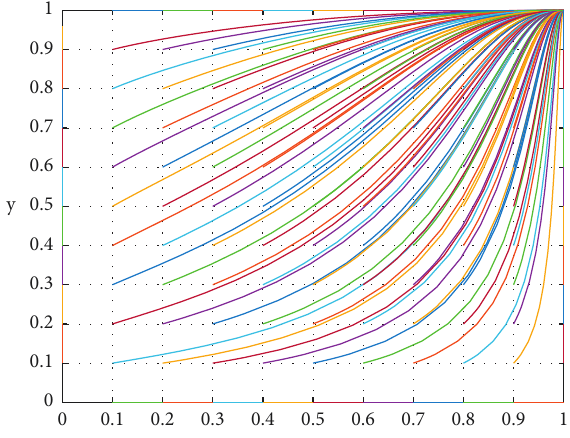
Figure 13: Evolution path when μ > α > ηβ and ε < ηβ − α <